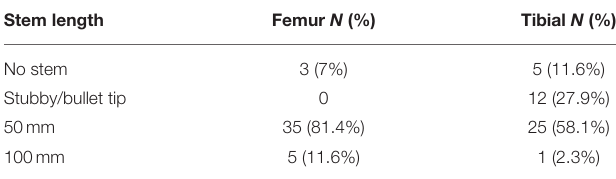
TABLE 5 | Stem length details.